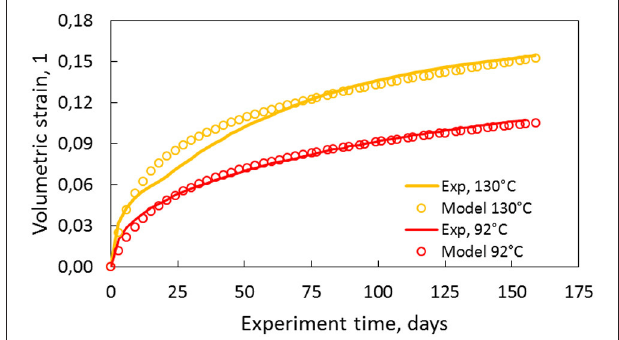
FIGURE 8 | Volume strain observed in solid lines for 130 and 92 ◦ C at 12.3 MPa effective stress. The open circles are the model proposed in the text where the values of n = 3 , α = 6 , and φ c = 0.375 were used to match the 92 ◦ C experiment, and n = 3 , α = 7 , and α = 0.355 were used to match the 130 ◦ C experiment. The value of β is used obtained from the experiment. α describes the exponential porosity evolution decay rate, and hence the rate of pore volume